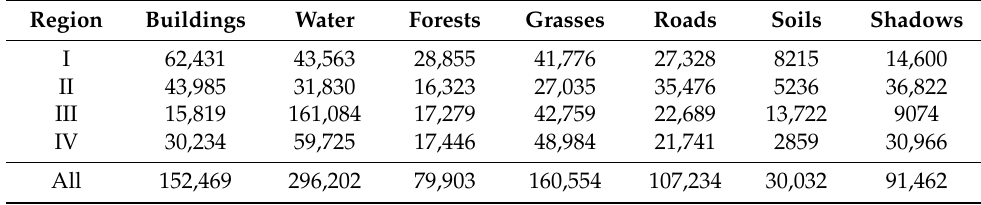
Table 2. Number of testing samples for each class in the test